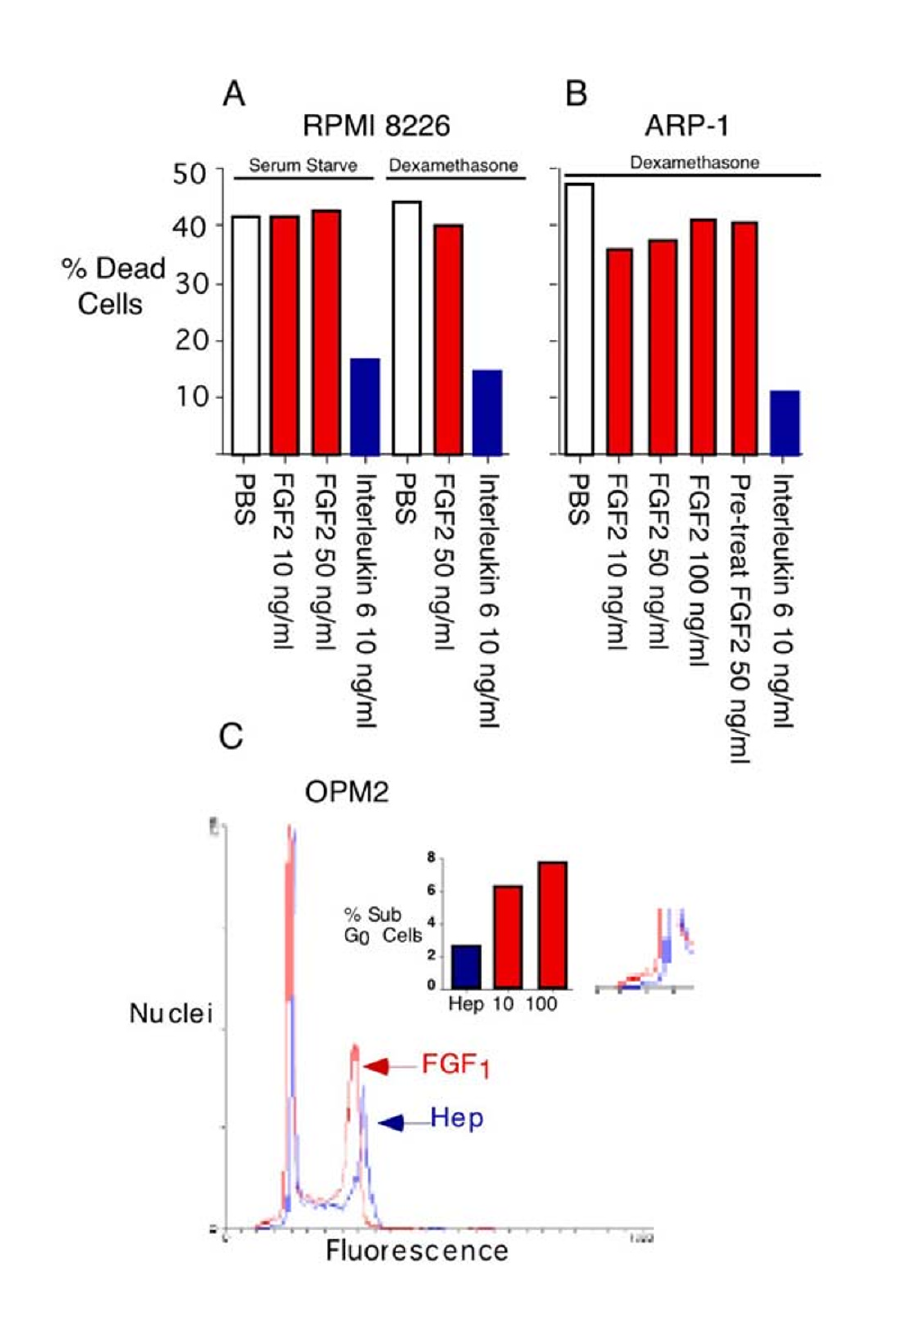
Figure 5 FGF Signaling Induces Cell Death in OPM2 Cells. A) RPMI 8226 myeloma cells were cultured in serum free medium for 24 hours or serum containing medium plus 10 uM dexamethasone (last three columns) in the presence of the indicated factors. The number of dead cells was evaluated using trypan blue exclusion two days after dexamethasone treatment. B) FGF signaling does not protect ARP-1 myeloma cells from dexamethasone-induced apoptosis. Conditions as in panel A. Pre-treatment con- sisted of pre-incubation of the cells with IL-6 for one hour, followed by death inducer. C) OPM2 cells were cultured in serum free medium for one day in the presence or absence of FGF1 and cell cycle analysis of ethidium bromide stained nuclei was performed. Results are representative of four independent determinations; p < .01 Student's paired t test. Red trace shows results with 100 ng/ml FGF1 as compared to heparin only (blue trace). Inset shows quantification of sub G 10 and 100 ng/ml FGF1 as compared to heparin alone and a magnified version of the sub G